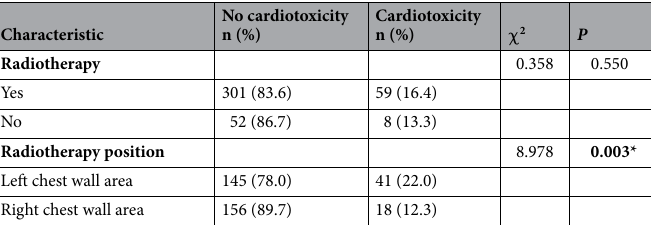
Table 2. Univariate analysis of cardiotoxicity associated with targeted therapy. Significant values are in [bold]. CAD coronary artery disease, H trastuzumab, HP trastuzumab and pertuzumab. * P < 0.05.